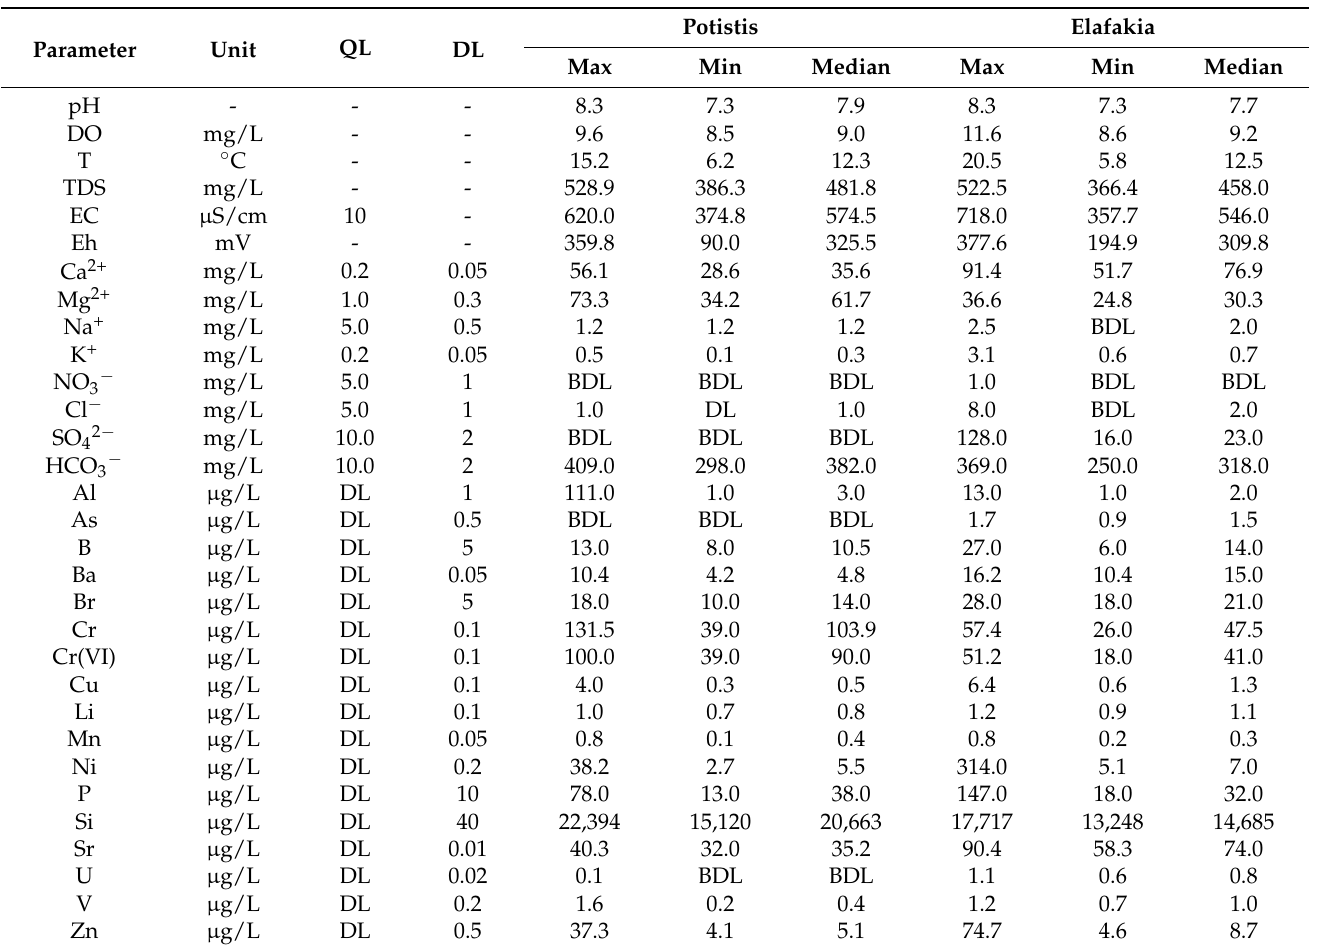
Table 2. Maximum, minimum, and median values of physical and chemical parameters of the natural springs in western Vermio